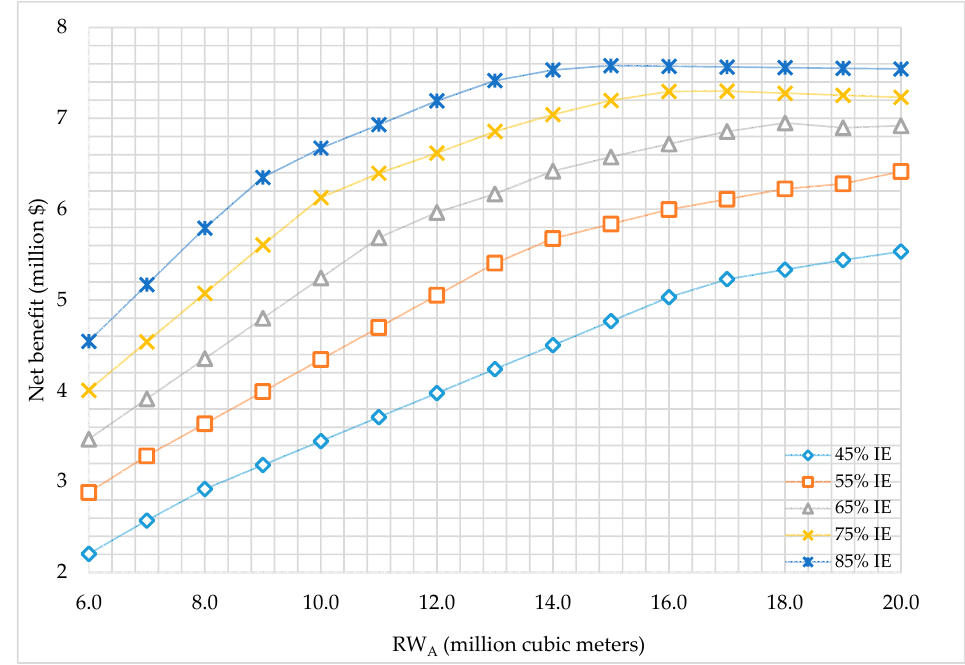
Figure 2. Total net benefit (million $) predicted using reclaimed water type A (RW A ) with five different irrigation efficiencies (IEs).